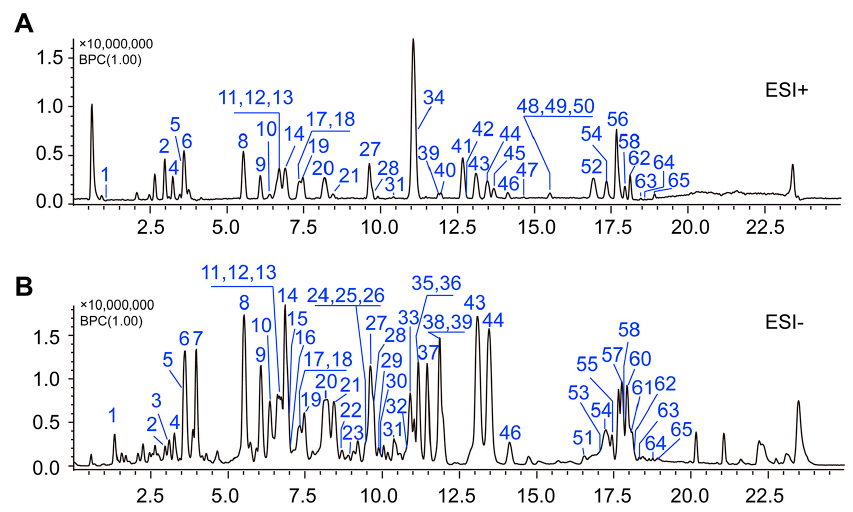
Figure 1. The base peak chromatograms (BPC) of YiQiFuMai injection by UFLC-IT-TOF/MS in negative ( A ) and positive ion mode ( B ).